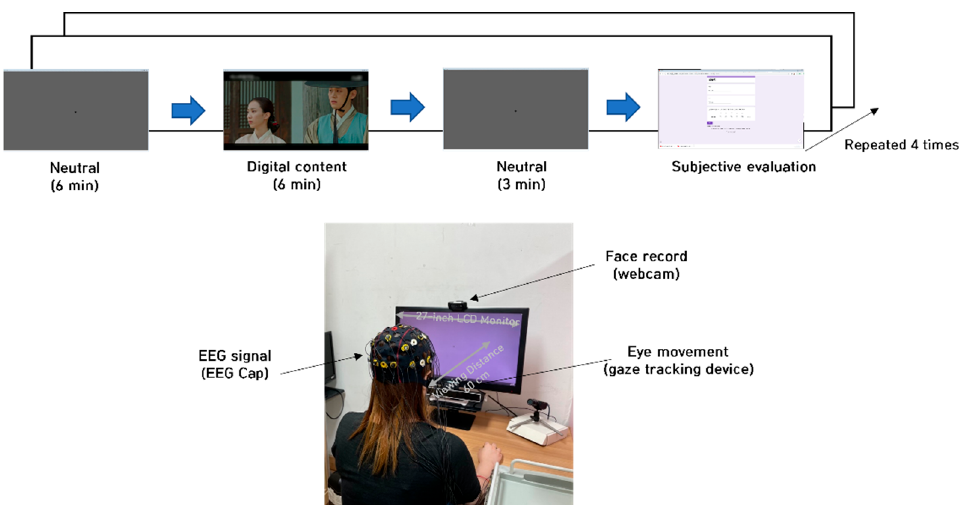
Figure 2. Experimental protocol and configuration.